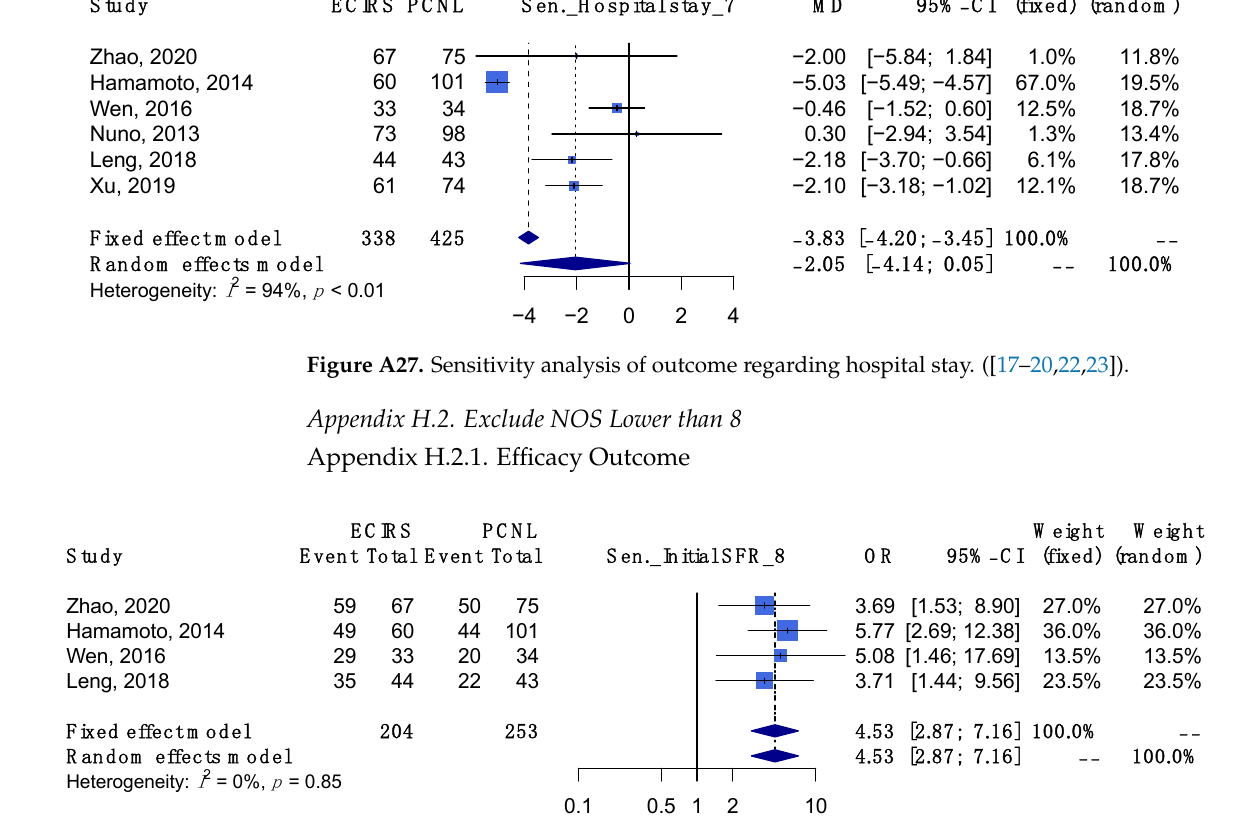
Figure A26. Sensitivity analysis of outcome regarding operative time. ([17–19,22,23])